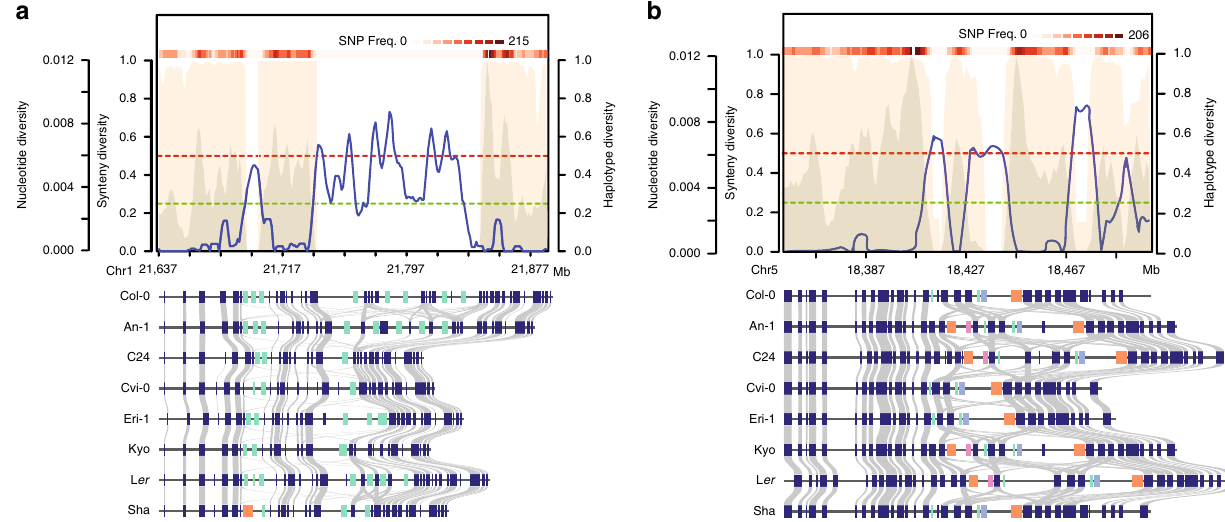
Fig. 4 Two examples for hotspots of rearrangements. Visualization of a the DM6 locus ( RPP7 ) and b an unnamed R gene cluster on chromosome 5. Descriptions for the plots can be found in the legend of Fig. 3d. Source Data are provided as a Source Data fi